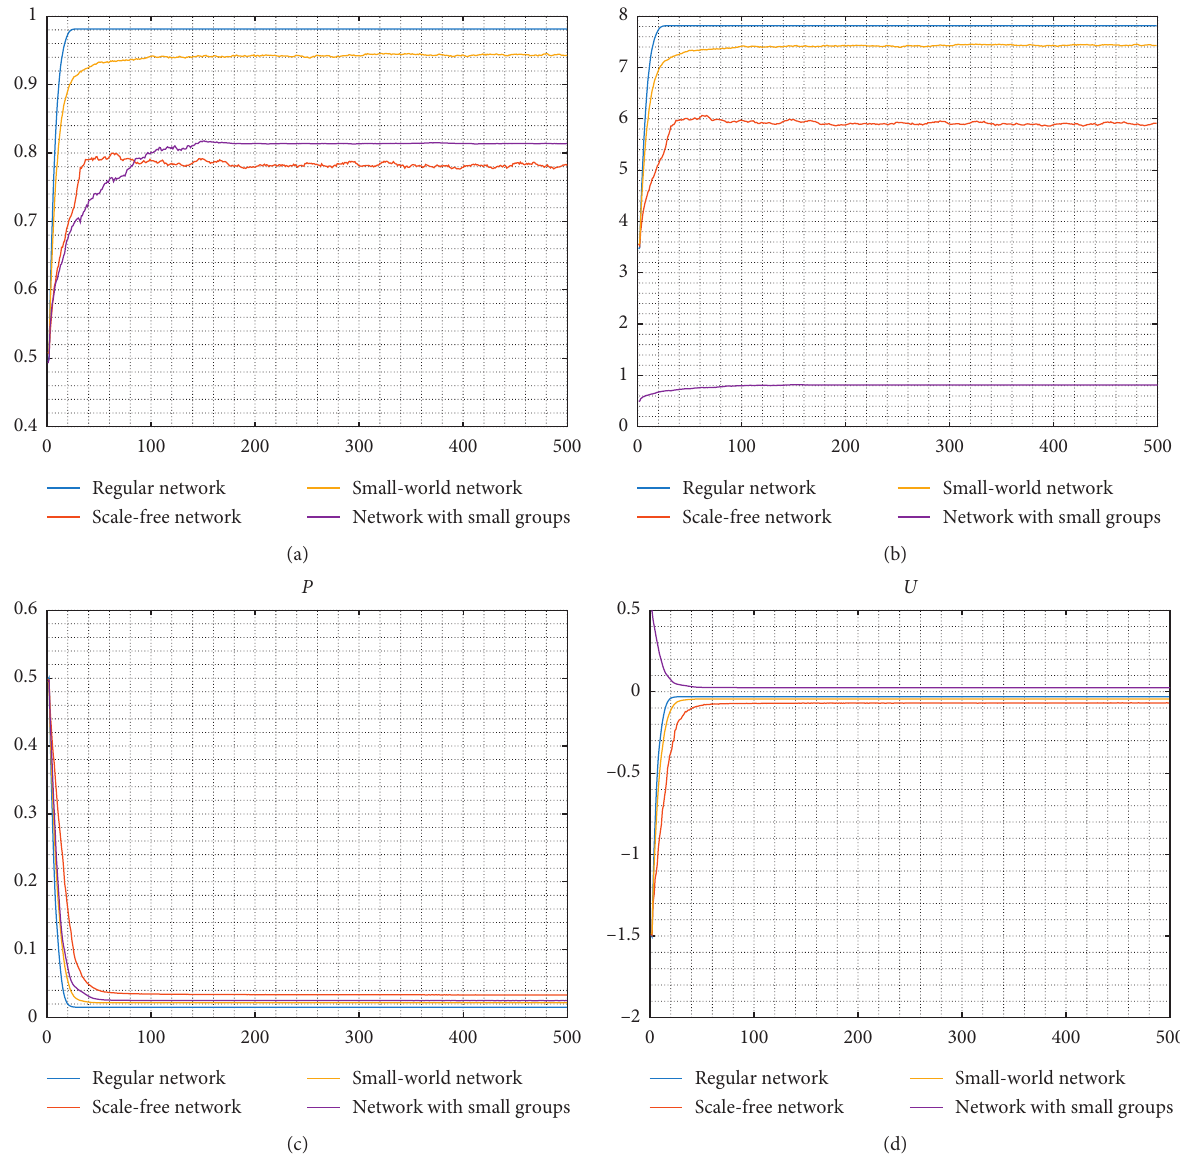
Figure 11: The simulated result considering the change of M and Group Size. (a) P (Case 1). (b) U (Case 1). (c) P (Case 2). (d) U (Case